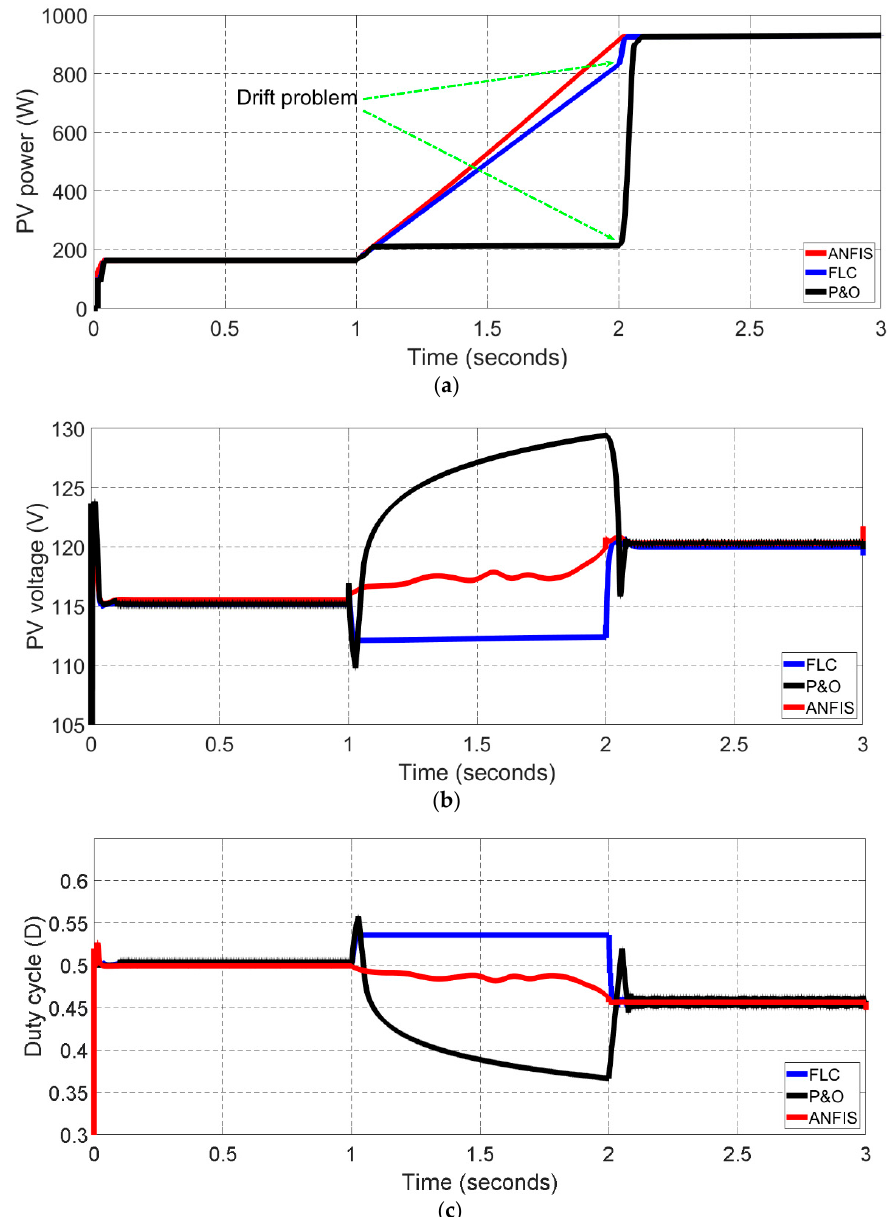
Figure 11. ( a ) PV array system for ANFIS versus the P&O and FLC methods under a rapid change in climatic conditions: ( a ) Power, ( b ) voltage, and ( c ) duty cycle.